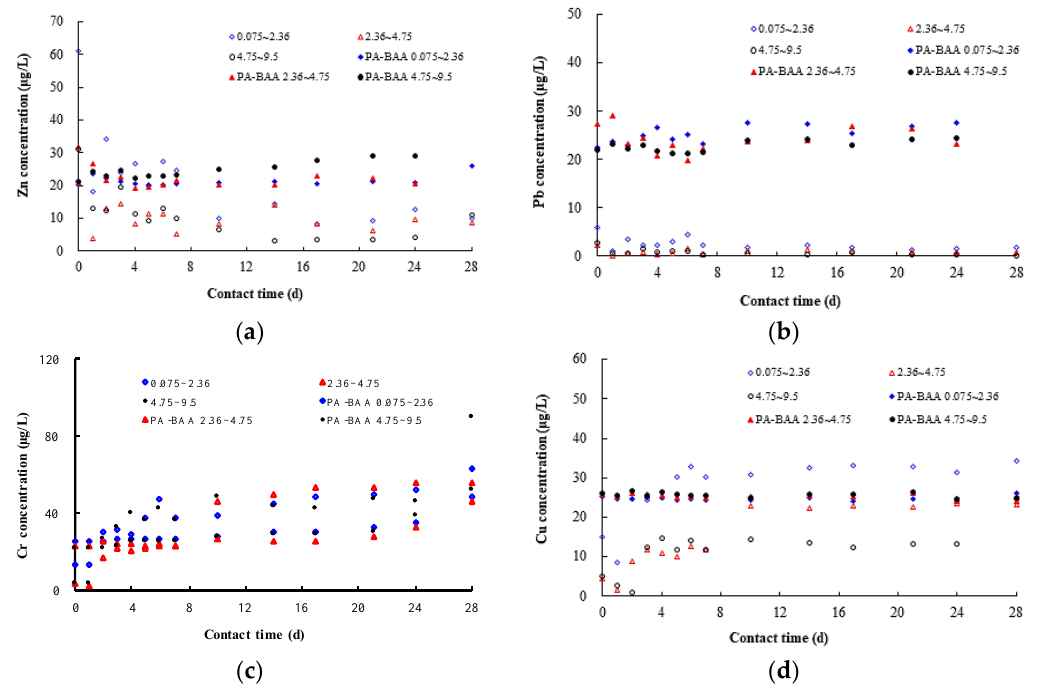
Figure 9. Leaching concentrations of heavy metals from unbounded MSWI-BAAs and PAC-13 specimens containing MSWI-BAAs: ( a ) Zn; ( b ) Pb; ( c ) Cr and ( d ) Cu.